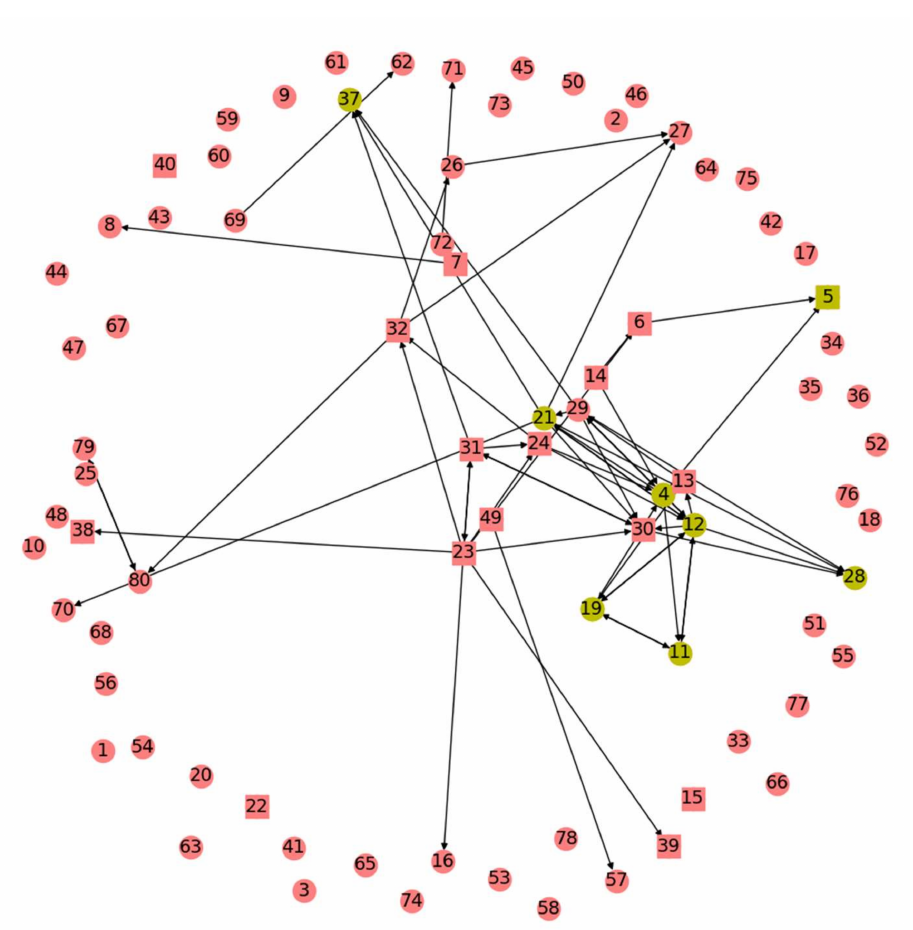
Figure 1. Results of one run of any of the graph algorithms tested can be visually depicted as shown. In this example, displayed are the Indegree Centrality results for one patient for one run of the algorithm. Axes here are arbitrary units from the GC map. Each number labels a node, with a square representing those in the SOZ and a circle representing all others. The top eight nodes by Indegree Centrality metric are yellow. Directed edges are shown. Figure produced using